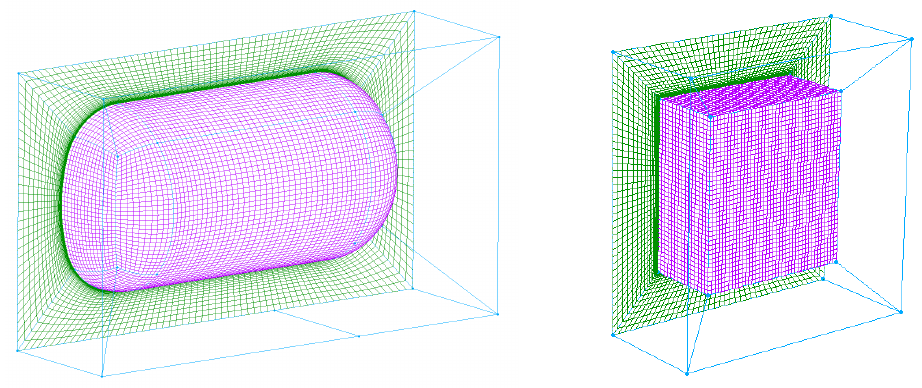
Figure 4. Three-dimensional schematic diagram of O-shape topology near the wall of a single dis- integration .